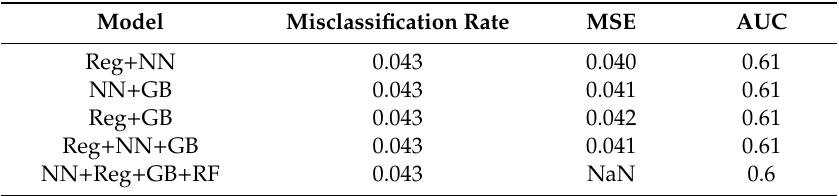
Table 16. Assembly results.